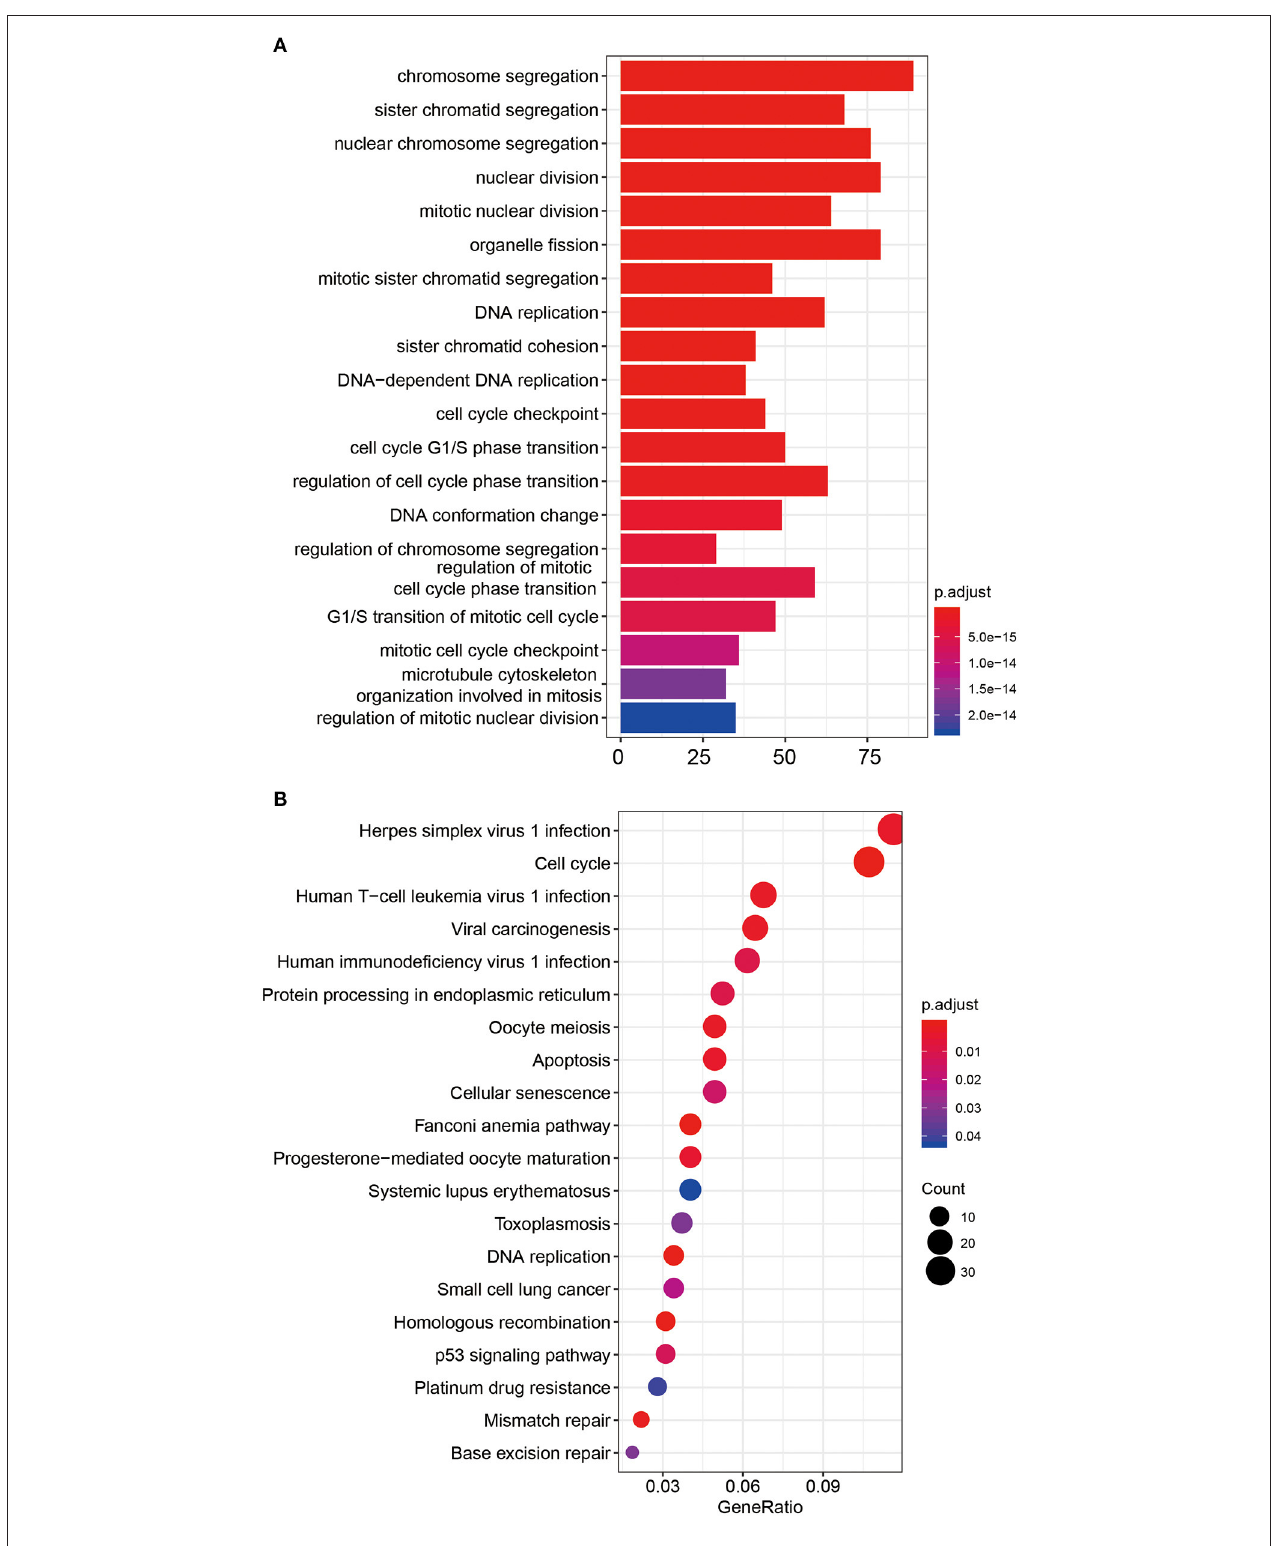
FIGURE 6 | GO (A) and KEGG (B) functional enrichment analysis of the five PCGs in the signature.